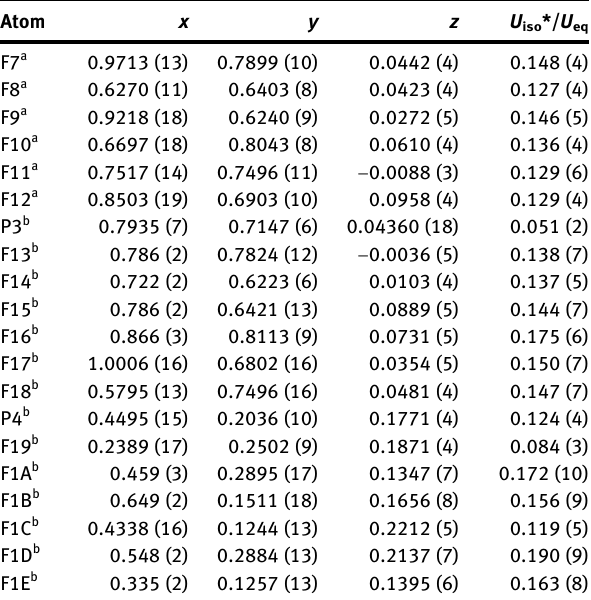
Table  : Fractional atomic coordinates and isotropic or equivalent isotropic displacement parameters (Å 